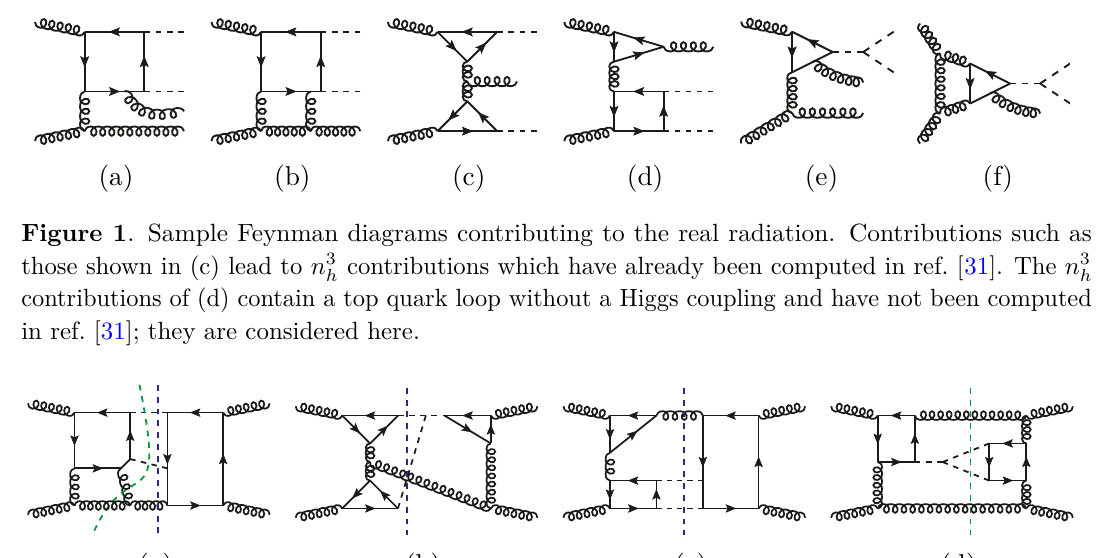
contributions as shown in (b) h